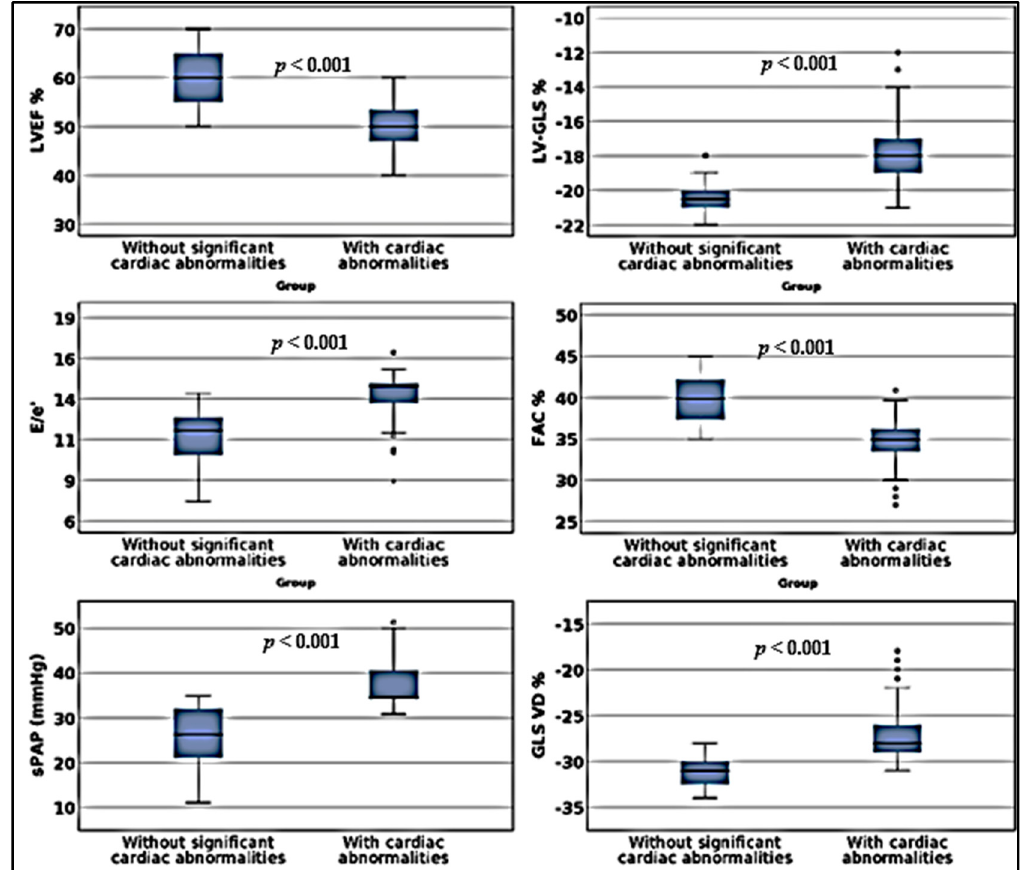
Figure 1. Prevalence of cardiac abnormalities in study groups. LVEF: left ventricular ejection fraction; LV-GLS: left ventricular global longitudinal strain; E/e ′ : early mitral inflow diastolic velocity E to average e ′ velocity (E/e ′ ) in pulsed tissue Doppler; FAC: fractional area change; sPAP: systolic pressure in the pulmonary artery; RV-GLS: right ventricular global longitudinal strain.